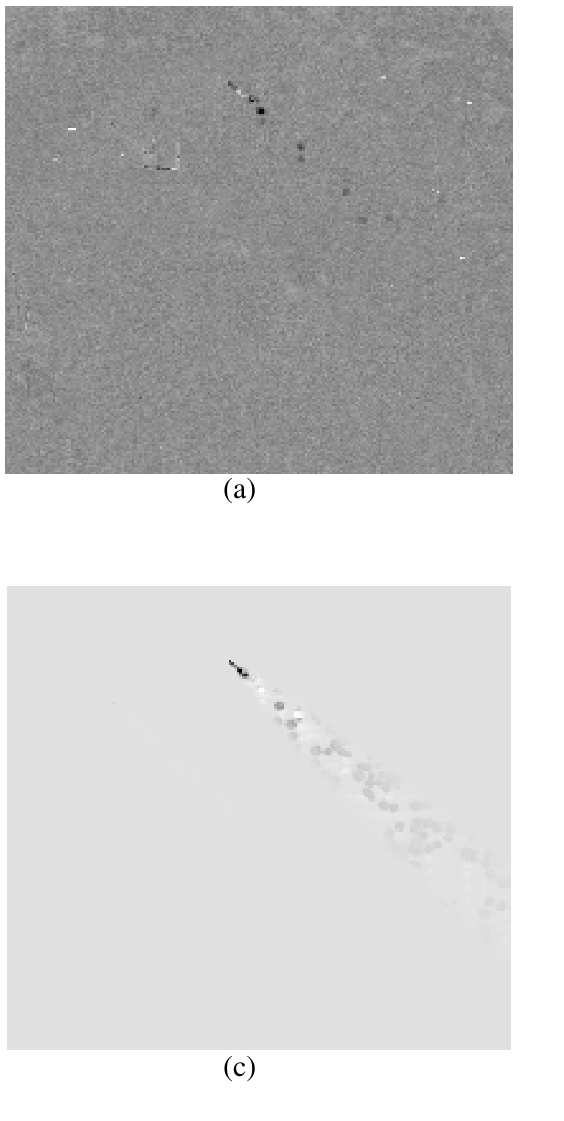
Figure 3. Images that show the GLS detection image for (a) Freon (scene-wide whiten- ing), (b) NH (scene-wide whitening), (c) Freon (background-only whitening) and (d) NH 3 (background-only